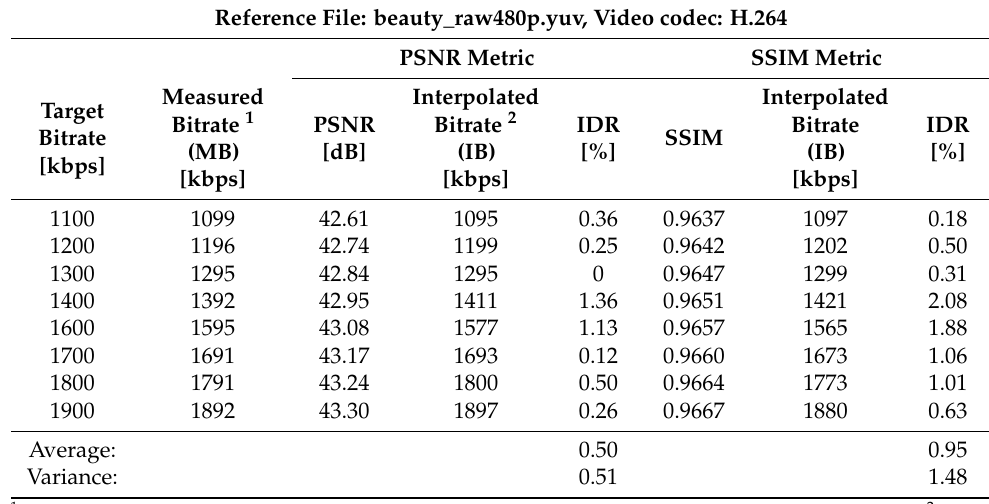
Table 2. Differences between the measured and interpolated coding bitrates for the H.264 codec.